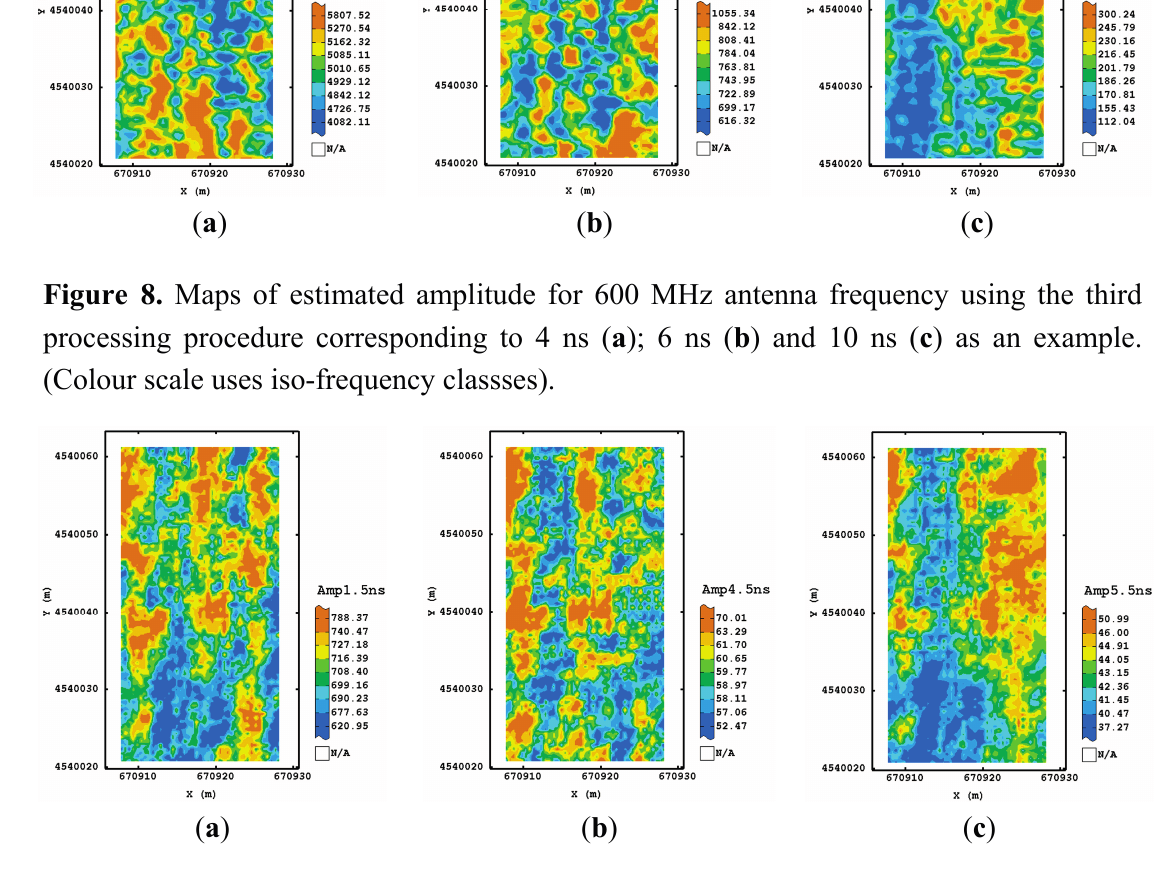
Figure 9. Maps of estimated amplitude for 1600 MHz antenna frequency using the third processing procedure corresponding to 1.5 ns ( a ); 4.5 ns ( b ) and 5.5 ns ( c ) as an example. (Colour scale uses iso-frequency